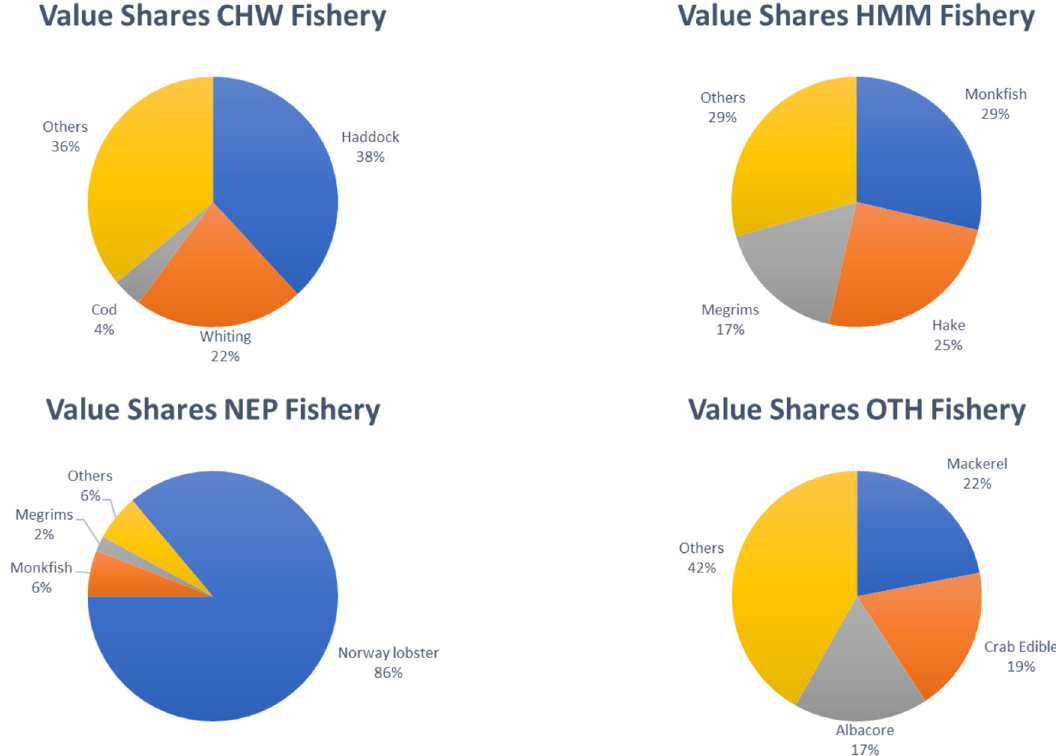
Fig. 5. Total landed value, in Euros, shares (%) of main species landed by the white fi sh fl eet within each fi shery (cod, haddock, whiting (cid:2) CHW; hake, monk fi sh, megrim (cid:2) HMM; nephrops (cid:2) NEP; all others (cid:2) OTH) in 2019 14